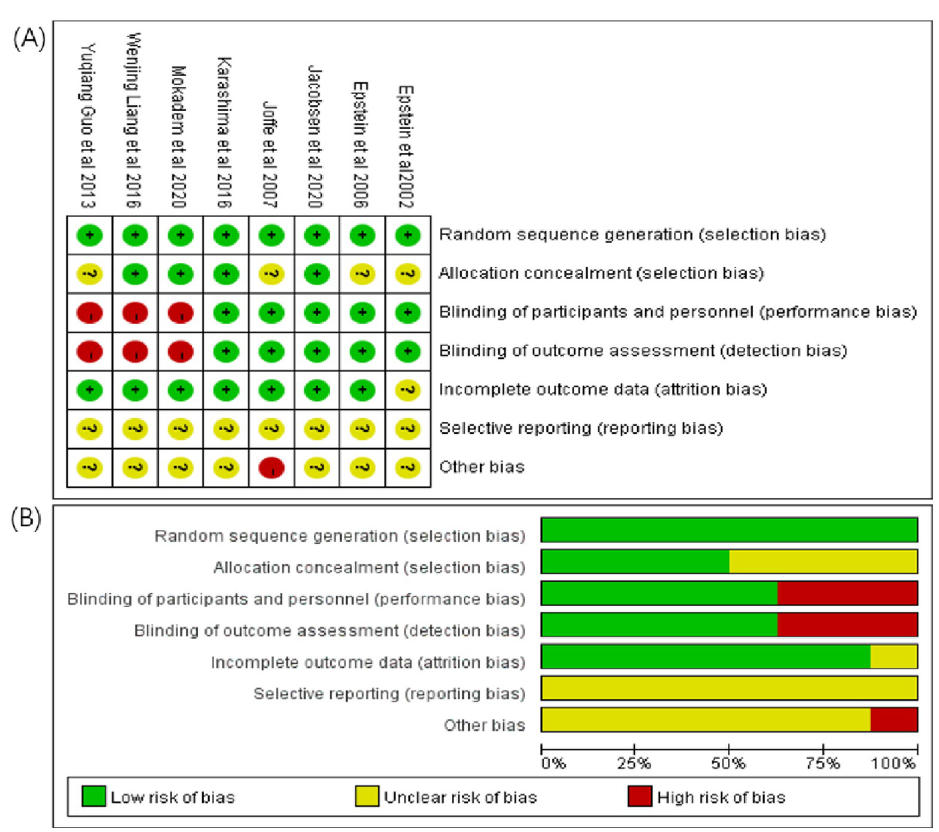
Fig 2. The risks of bias. (A) Risk of bias summary: review authors judgements about the respective risk of bias item for the respective included study. (B)Risk of bias graph: review researchers’ judgements about the respective risk of bias item presented as percentages across all included